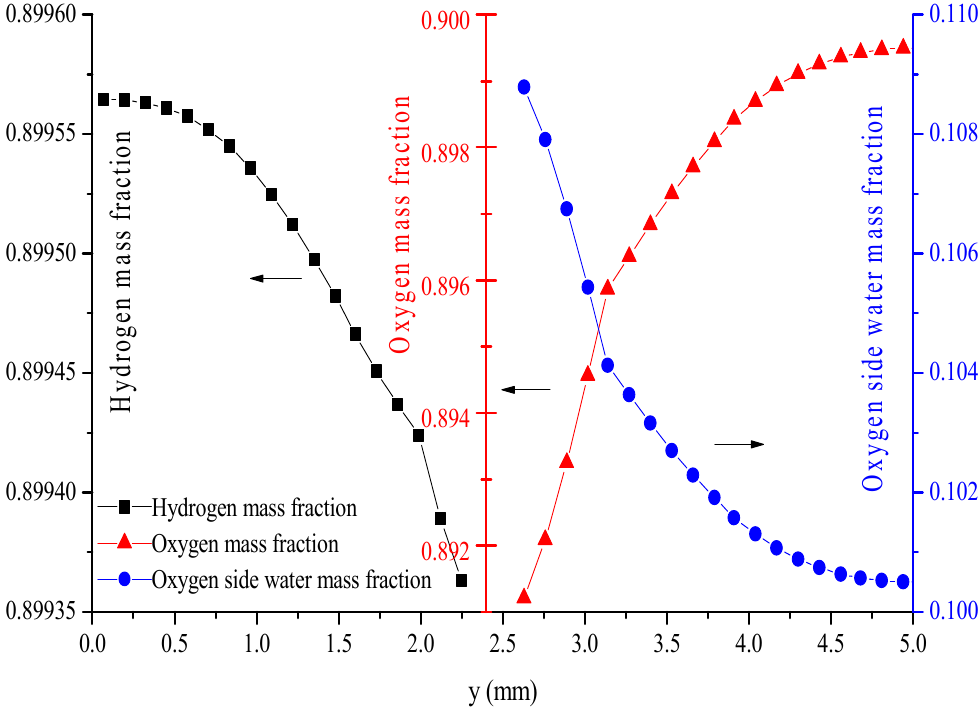
Figure 6. Parameter distribution along line A–A at 0 s.